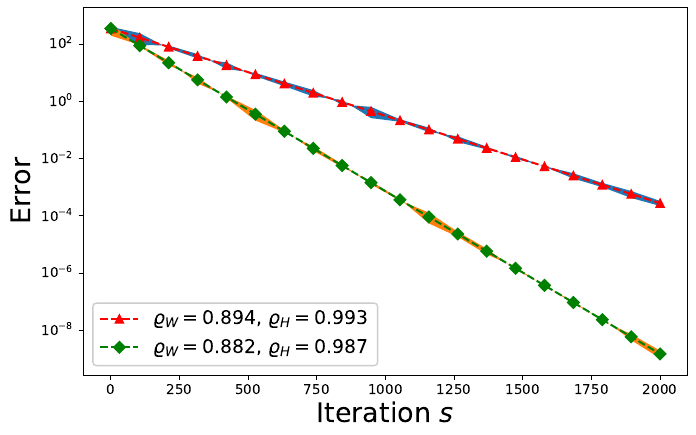
Figure 5. The effect of (cid:36) H on the convergence of a random inconsistent